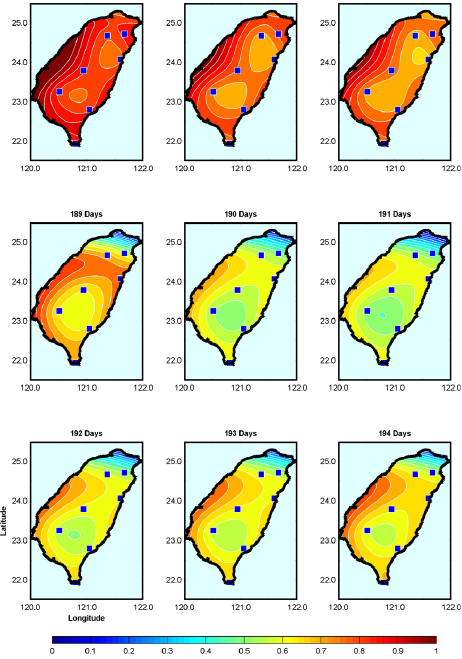
Fig. A6. A contour map of the cross correlation values from nighttime data during the Tohoku earthquake (on 192nd